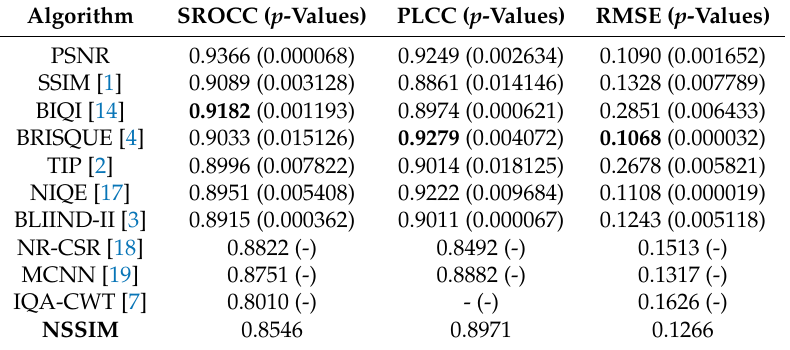
Table 6. Comparison with ten existing IQA algorithms on CSIQ dataset (150 Gaussian blur images). We take Spearman’s rank order correlation coefficient (SROCC), Pearson linear correlation coefficient (PLCC) and root mean square error (RMSE) as evaluation indexes. In each column, the best performance value is marked in